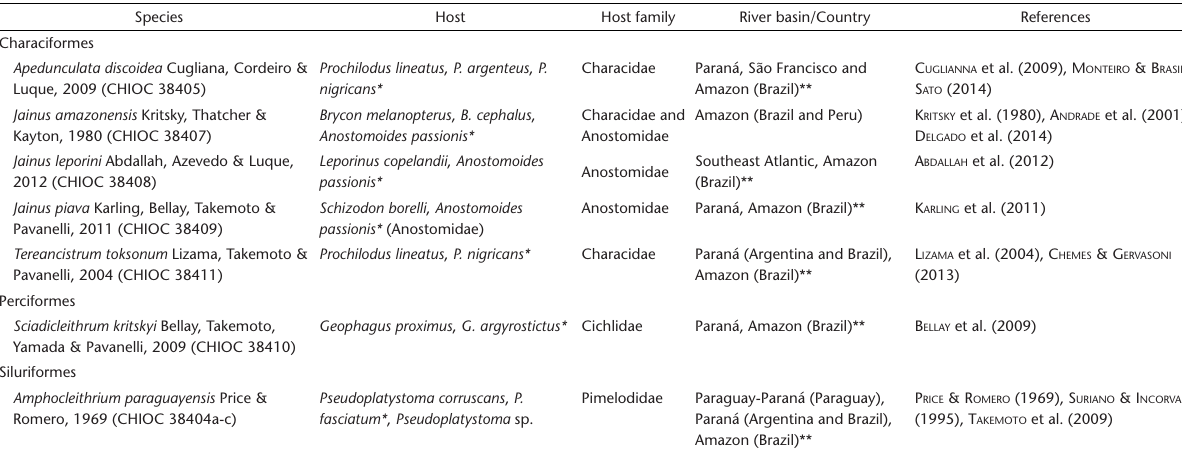
Table 1. New host and geographical records of dactylogyrids parasitizing fish from the Xingu River, Amazon basin, Brazil. Species Host Host